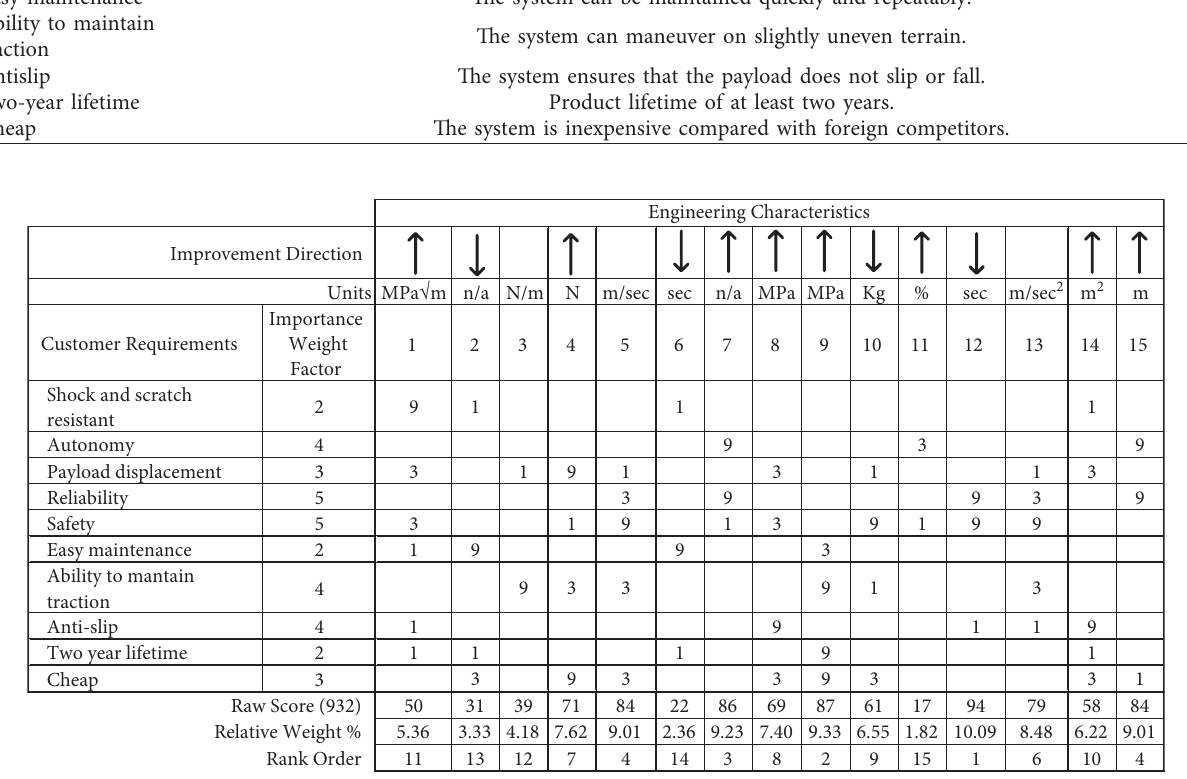
Figure 2: House of quality of the vehicle.